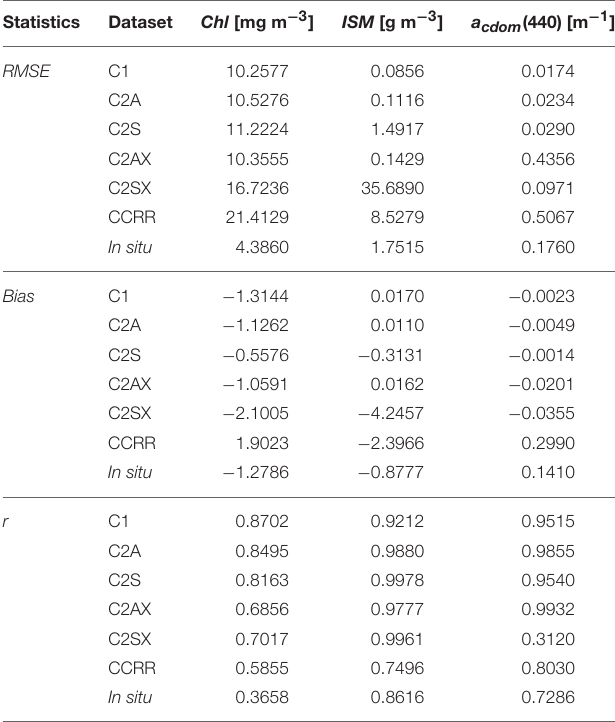
TABLE 3 | Statistics of ONNS retrievals vs. test